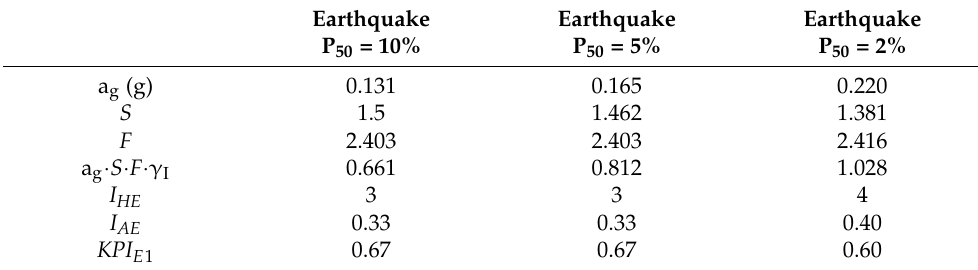
Table 8. KPI E 1 for the three considered seismic